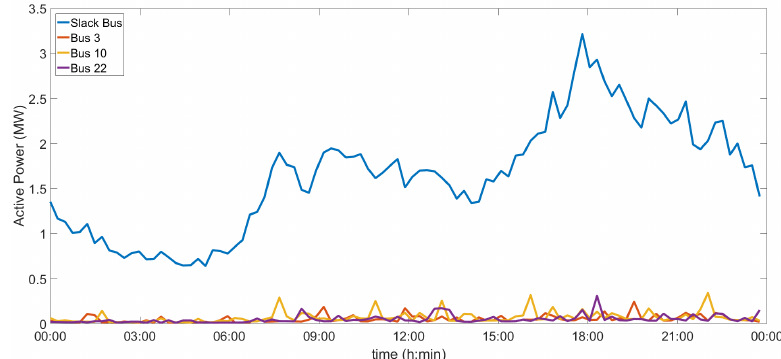
Figure 8. Daily load profiles of Slack Bus and Buses 3, 10 and 22 of the 33 Bus System.